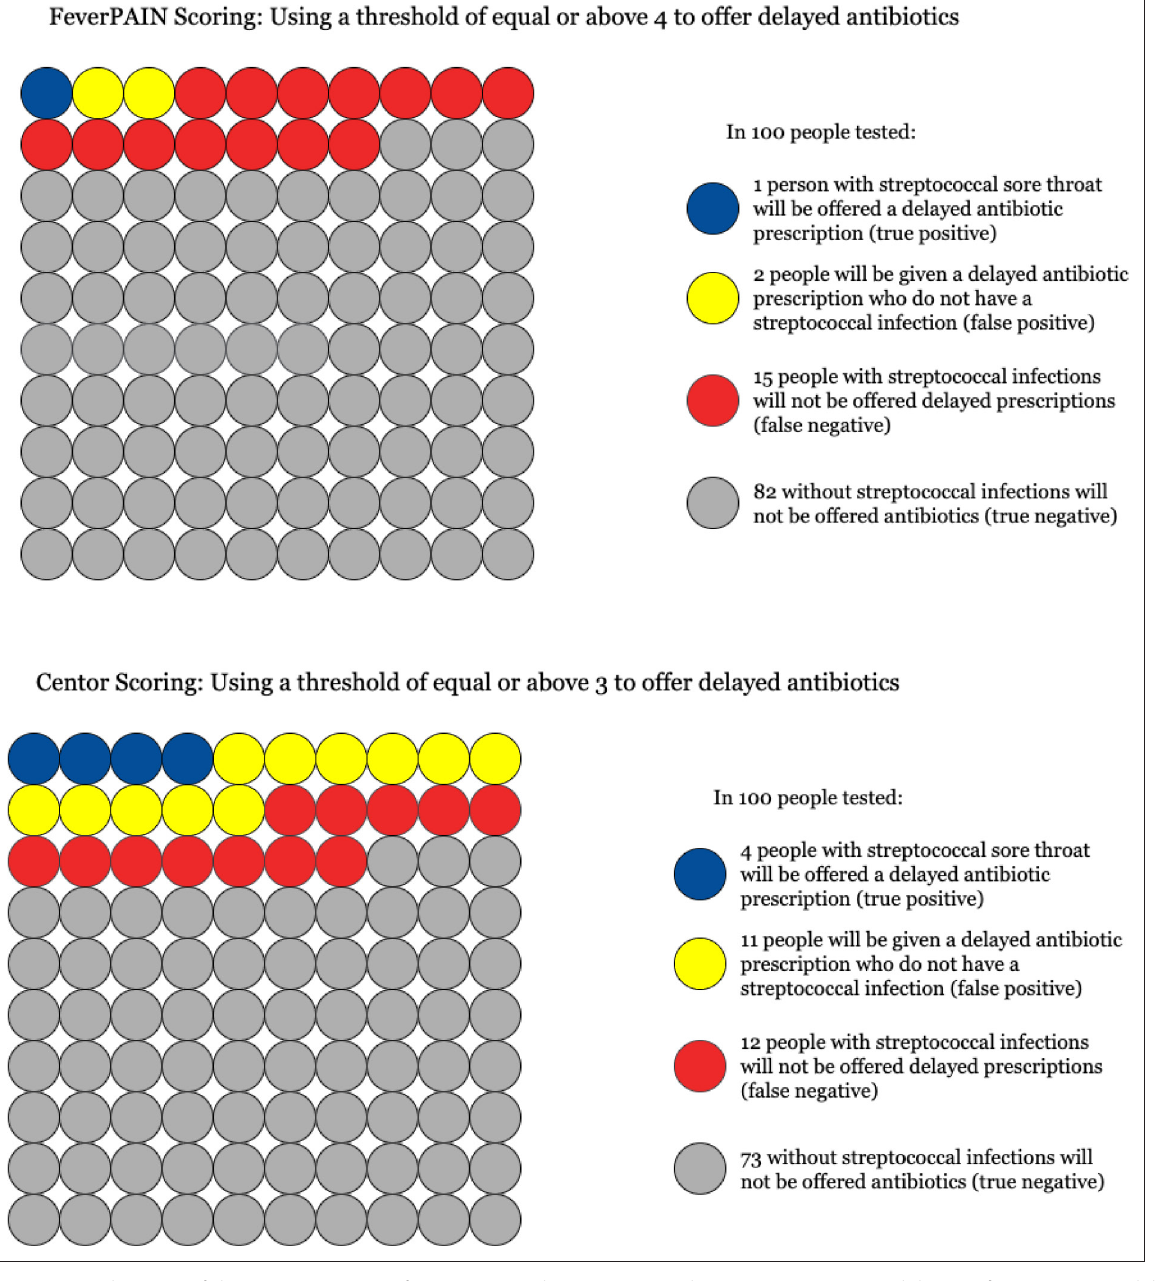
Figure 3 Implications of diagnostic accuracy of FeverPAIN and Centor CPR in diagnosing streptococcal throat infections in 100 adults presenting with sore throat not deemed to require immediate antibiotics. The diagram illustrates how both CPR scores would operate if used on 100 people presenting with sore throat, based on a similar prevalence (16%) of streptococcal infection, as found in the present study. Different colours indicate possible outcomes: true positive (blue), false positive (yellow), false negative (red), and true negative